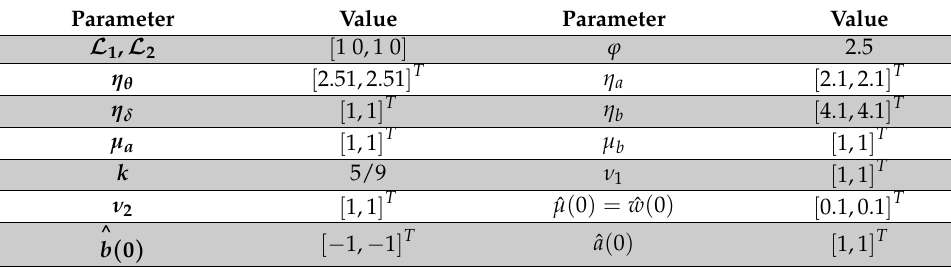
Table 5. Design parameters.